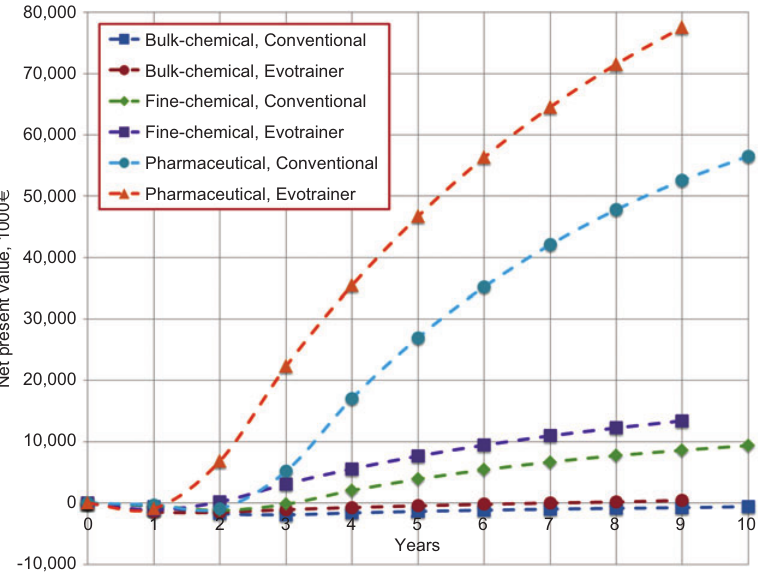
Figure 9 Net Present Value for comparison of the three chemical product classes (200